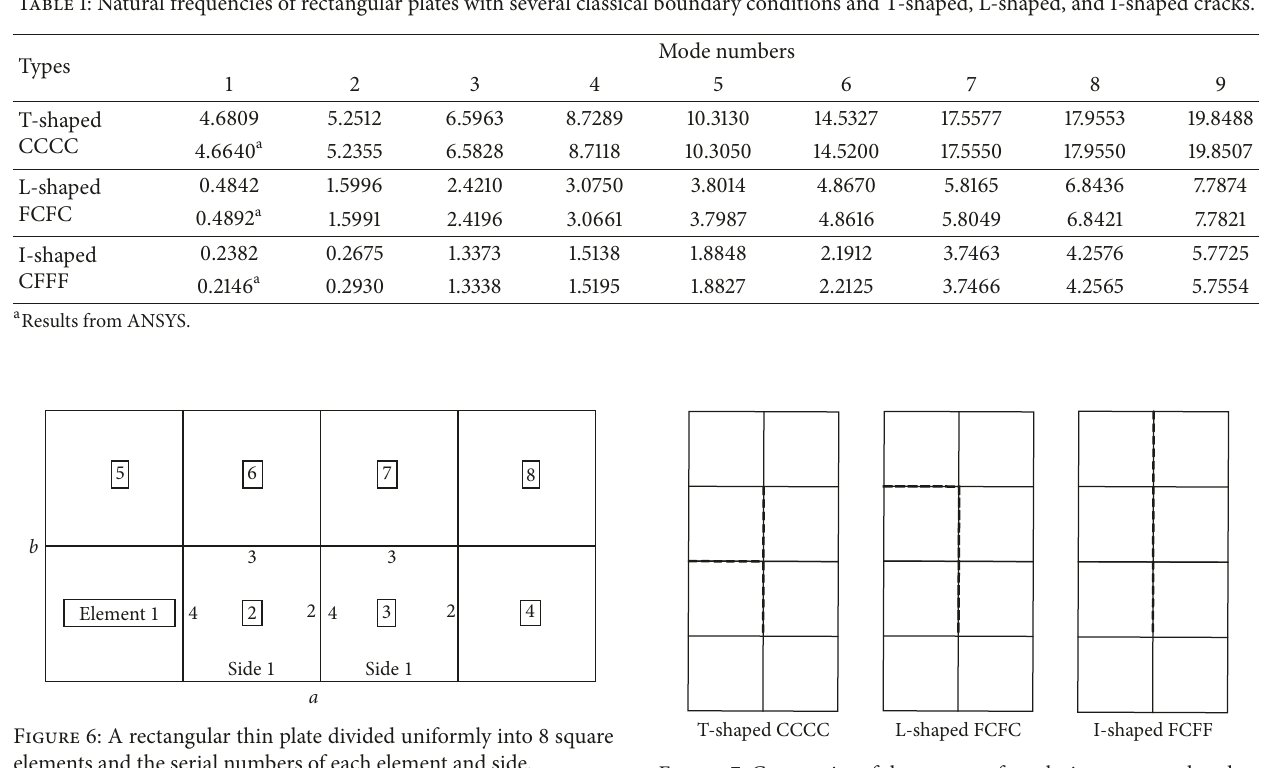
Figure 7: Geometries of three types of cracks in a rectangular plate and the boundary